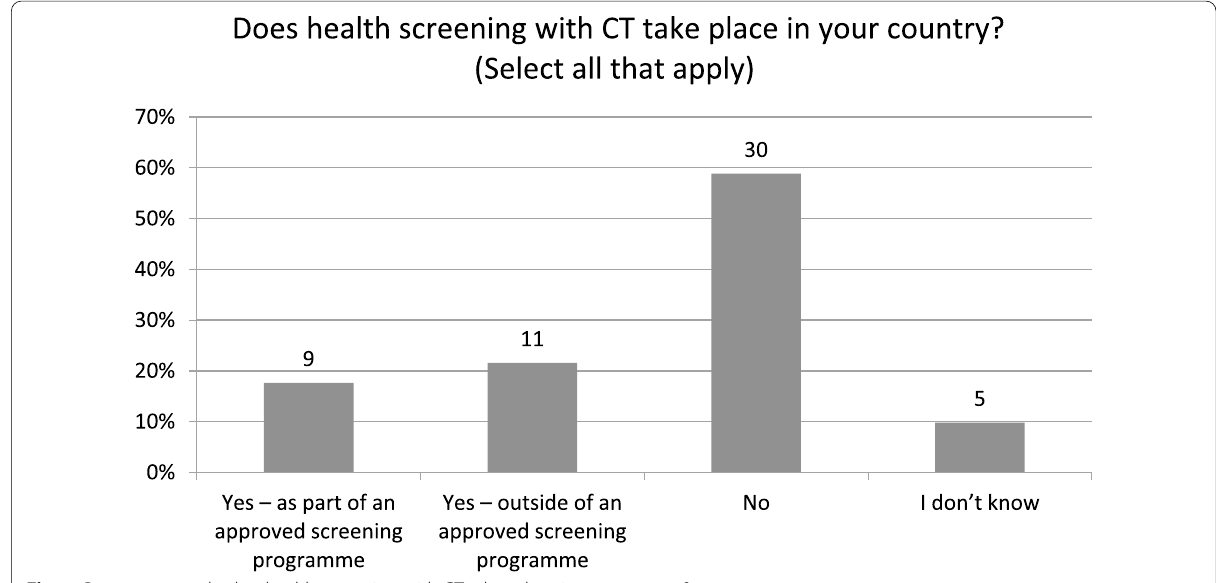
Fig. 5 Responses to whether health screening with CT takes place in your